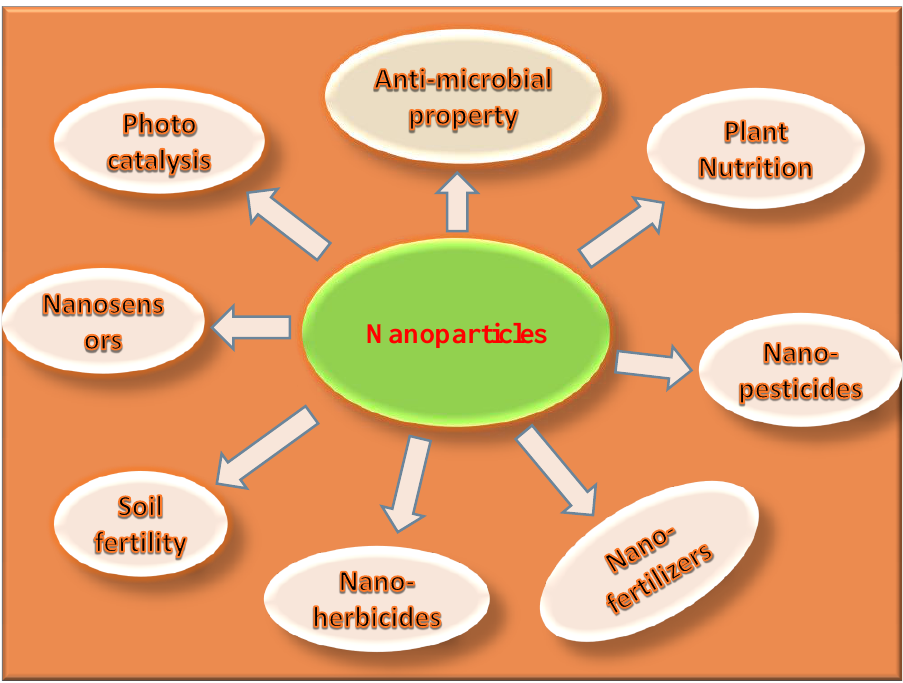
Figure 4. Diagram showing general applications of nanoparticles in agriculture